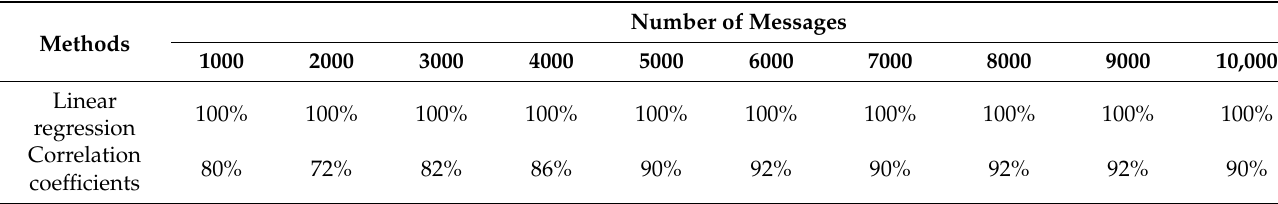
Table 11. The influence of different message counts on accuracy.